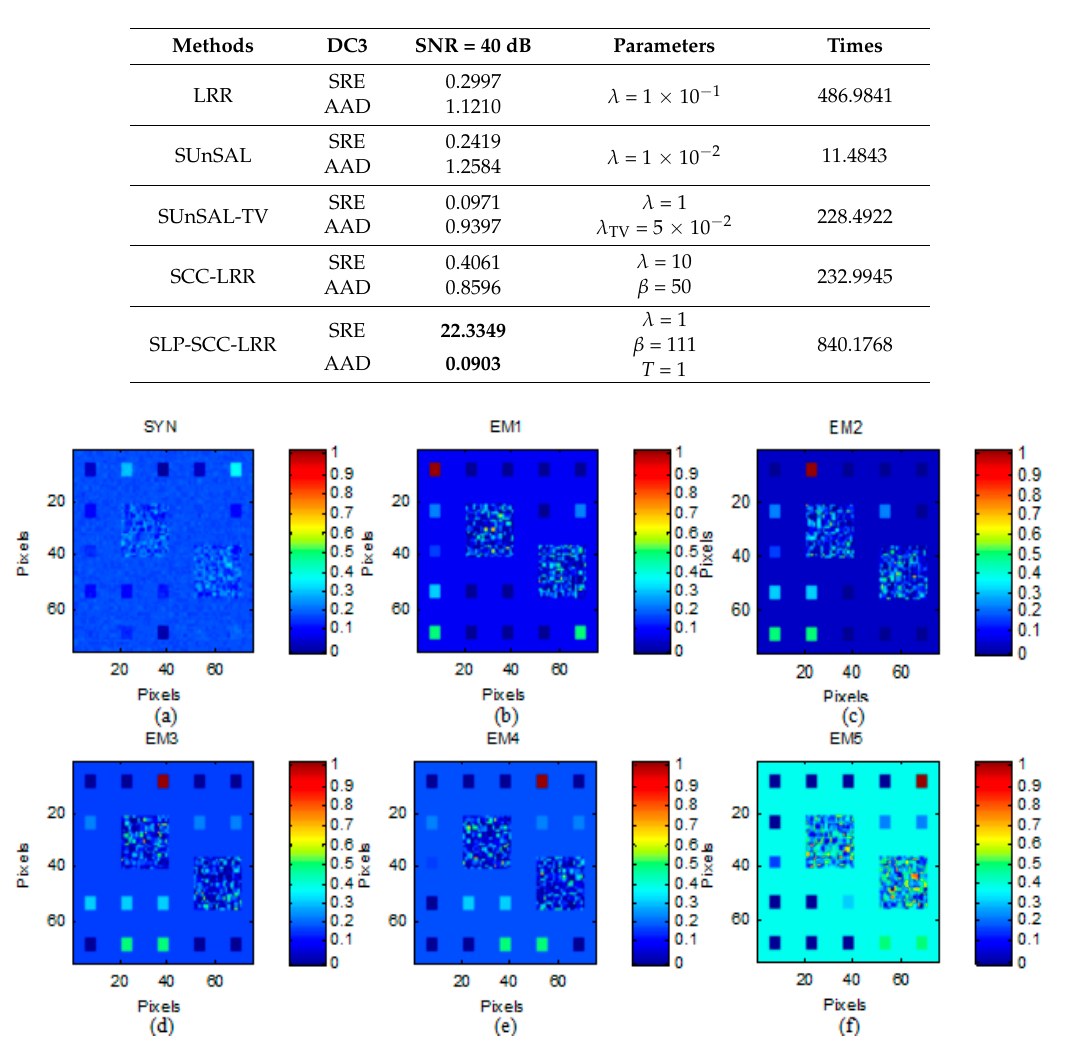
Table 5. SRE (dB) and AAD values to Simulated Dataset 3 with the parameter settings and running times.